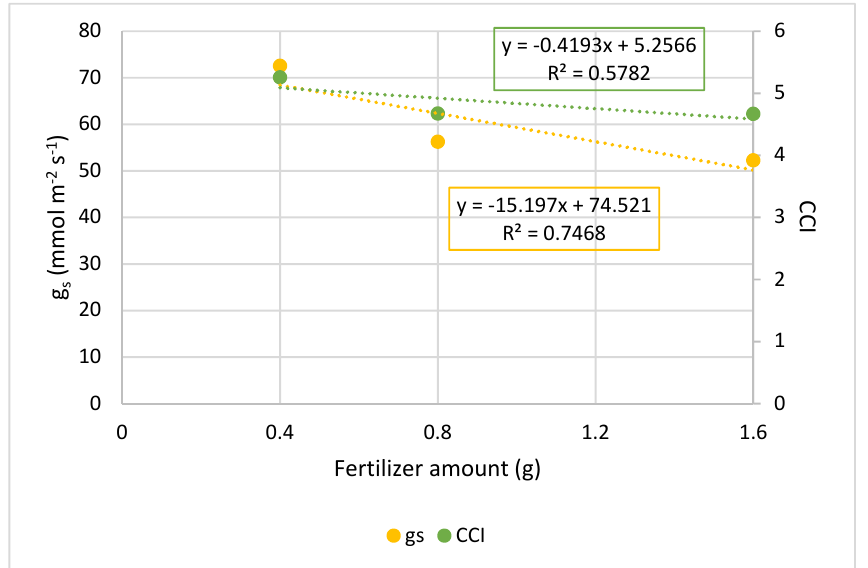
Figure 3. Linear regressions established between the stomatal conductance (g s ) and the chlorophyll content index (CCI), and the applied CRF doses. Table 6. Effect of different concentration of CRF on stomatal conductance (g s ) and chlorophyll content index (CCI).